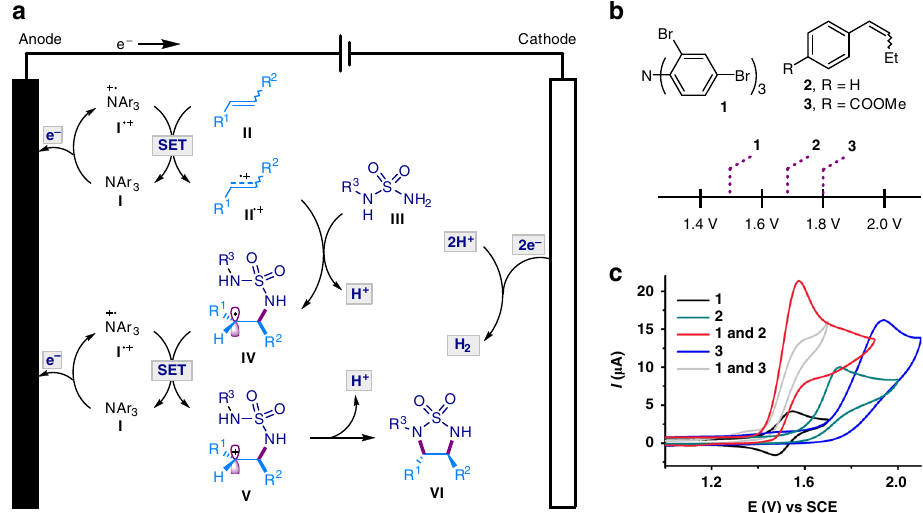
Fig. 2 Proposed reaction design. a The proposed reaction mechanism. The process combines anodic oxidation and cathodic proton reduction to achieve the alkene 1,2-diamination via H 2 evolution. The electrocatalytic activation of the alkene through single-electron transfer (SET) oxidation generates the alkene radical cation II (cid:129) + , which is trapped by the sulfamide III to give radical IV . Further SET oxidation and diastereoselective cyclization of V afford diamination product VI . The cathode reduces protons to generate H 2 . b Oxidation potentials [ E p/2 vs Saturated calomel electrode (SCE)] of triarylamine 1 and alkenes 2 and 3 . c Cyclic voltammetry. The studies show that triarylamine 1 can catalyze the oxidation of aryl alkenes 2 and